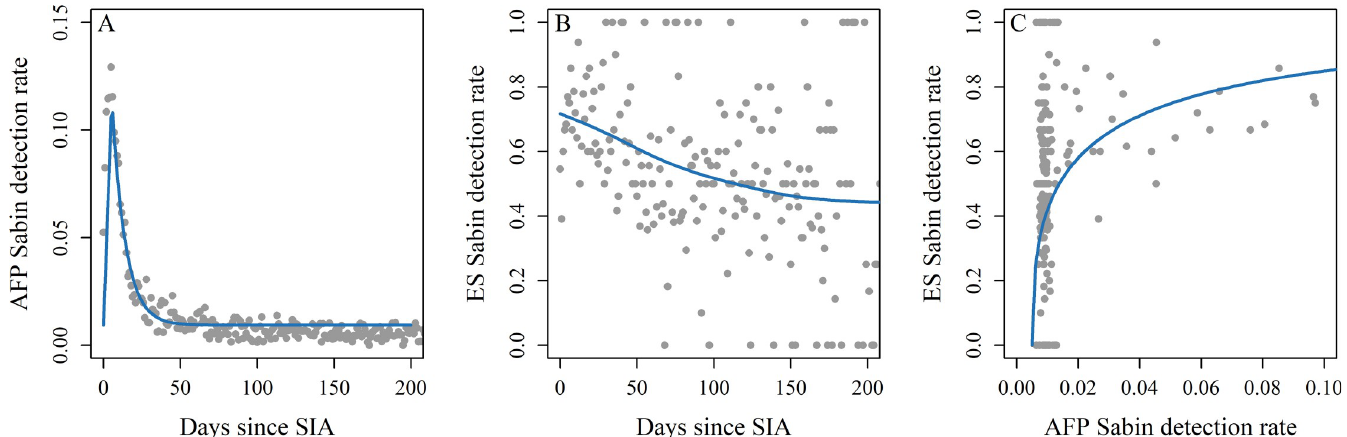
Fig 1. Sabin-like type 2 (SL2) detection rates in AFP and ES after mass supplemental immunization activities (SIA) in Pakistan. Panel A and B illustrate how the raw detection rates of SL2 in AFP and ES decline after OPV2 use in an SIA (either mOPV2 or tOPV). The ES data exhibit much more noise than AFP, partly due to the smaller sample size of ES and to the noisier nature of ES data. Panel C shows that raw detection rates of SL2 in ES increase as SL2 prevalence increases (prevalence estimates from model built in panel A). The grey dots are data from across all of Pakistan and the blue lines indicate mean model estimates.